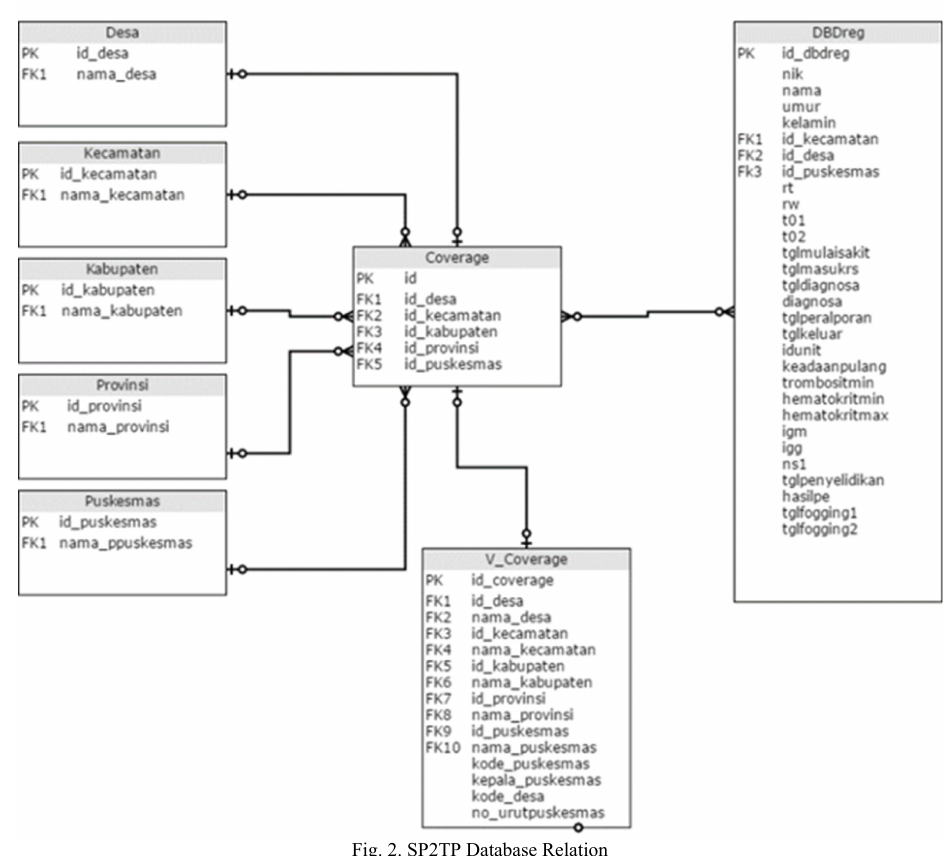
Fig. 2. SP2TP Database